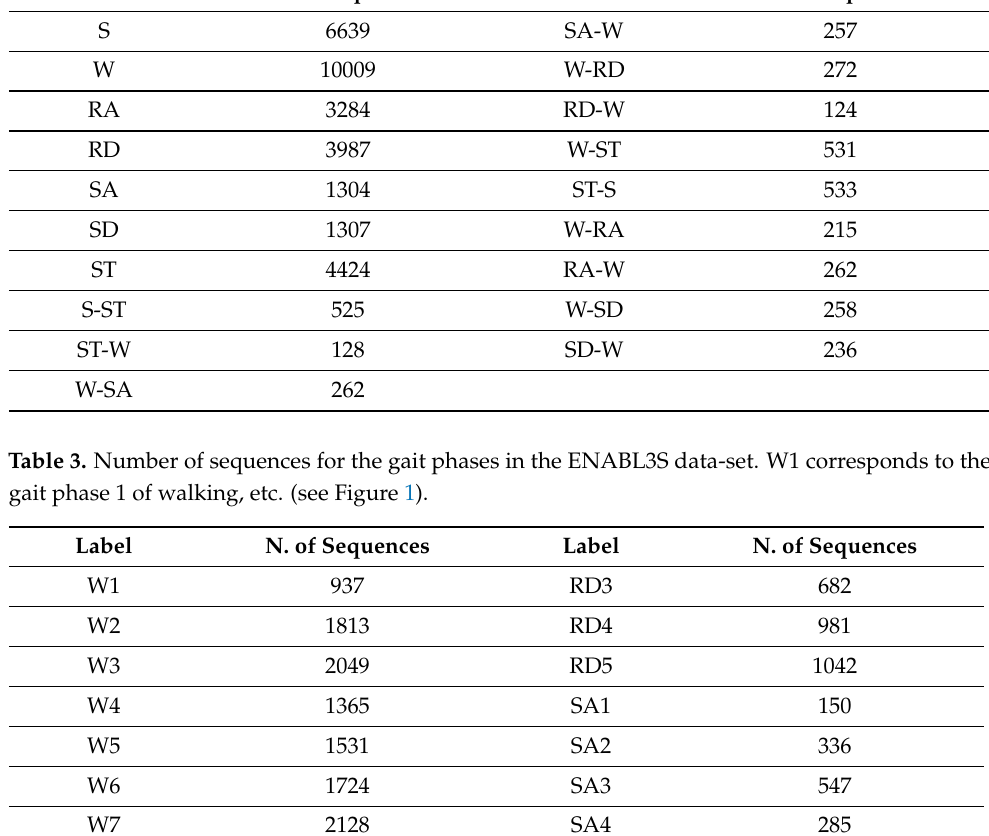
Figure 2. Example of sequence extraction. The original data-set is represented in grey with its original labels. The sequences (with a size of 1.3 s and a sliding window of 50 ms) are represented in yellow/green/blue and are relabeled as explained in Section 2.2.1. Table 2. Number of sequences for locomotion modes and transitions in the ENABL3S data-set. N. of Sequences